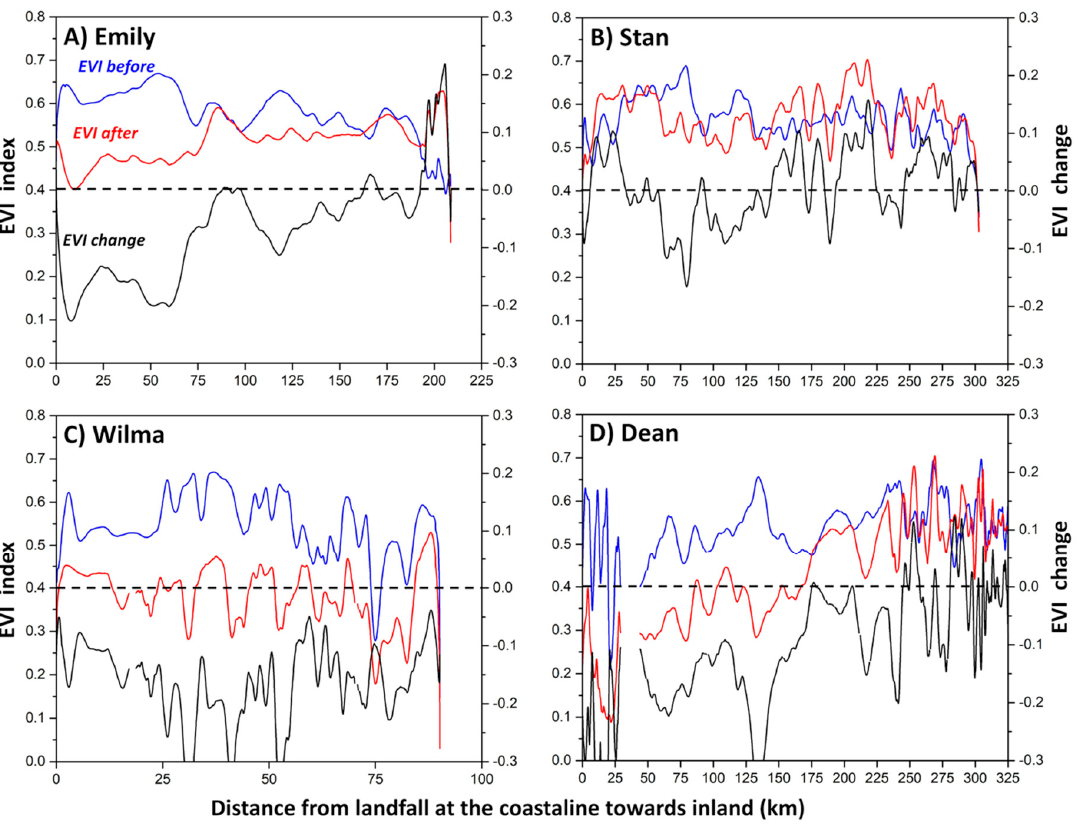
Figure 9. Enhanced Vegetation Index (EVI) profiles along the Yucatan Peninsula portion of selected tropical cyclones (TCs) tracks: ( A ) Emily, ( B ) Stan, ( C ) Wilma, and ( D ) Dean; TCs trajectory and direction are shown in Figure 7. Blue is before and red after landfall; the zero value in the X-axis is the landfall location; notice the di ff erence in the X-value range per storm. The index di ff erence between the value after and before landfall is in black (EVI change; right Y-axis). A negative di ff erence means that the index is lower after landfall.